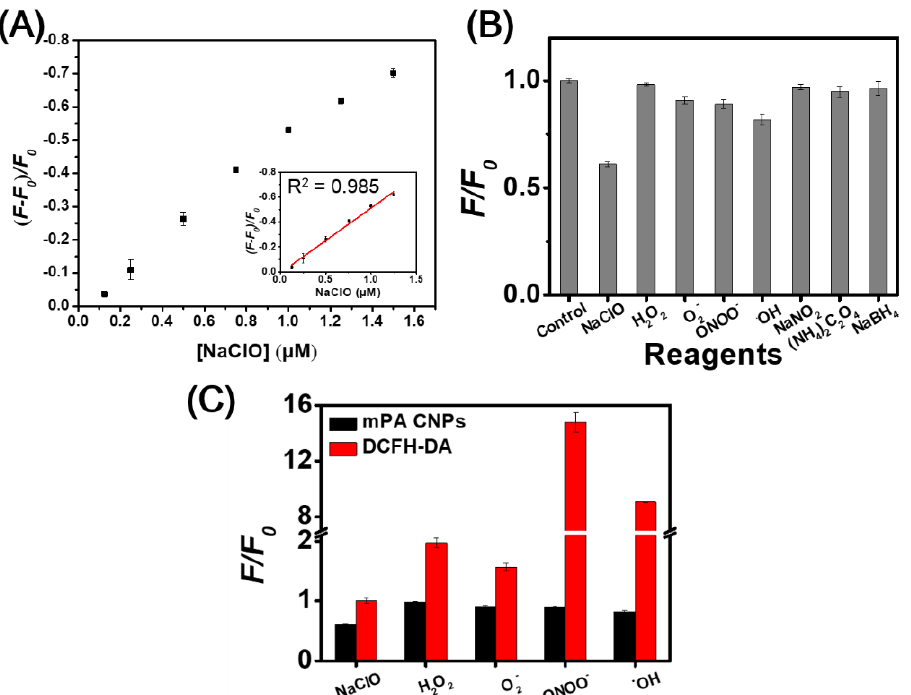
Figure 4. ( A ) Plot of the fluorescence reduction of mPA CNPs versus hypochlorite concentration. The linear relationship between (F-F 0 )/F 0 and NaClO concentration ranges from 0.125 to 1.5 μM. F 0 and F denote the fluorescence intensities of mPA CNPs at 500 nm in the absence and presence of hypochlorite. Excitation wavelength is 400 nm. ( B ) Effects of potential interferences on fluorescence intensities of mPA CNPs (5 μg mL −1 ) at 500 nm in 20 mM phosphate buffer (pH 7.4). The concentra- tions of NaClO and ONOO − are both 10 μM and the concentration s of H 2 O 2 , O 2 − , OH, NaNO 2 , (NH 4 ) 2 C 2 O 4 , and NaBH 4 are all 100 μM. ( C ) Fluorescence intensity changes of mPA CNPs (5 μg mL - 1 ) or DCFH- DA (25 μM) in 20 mM phosphate buffer (pH 7.4) toward various ROS and ONOO − . F 0 and F denote separately the fluorescence intensities of respective probe in the absence and presence of different analytes. DCF fluorescence is detected by using excitation and emission wavelengths of 485 and 535 nm, respectively.